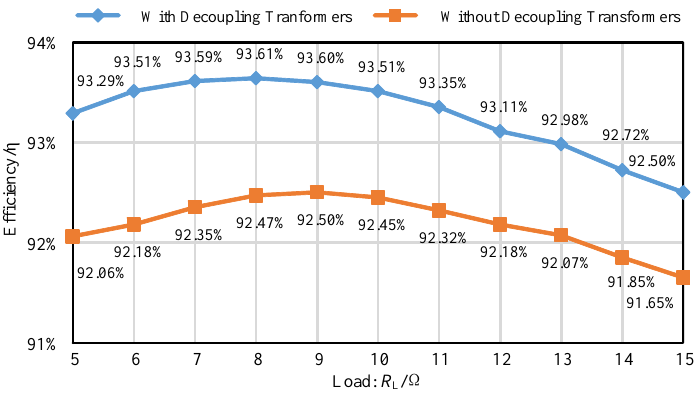
Figure 11. Optimal efficiency results: ( a ) capture of the power analyzer; ( b ) power loss distribution.